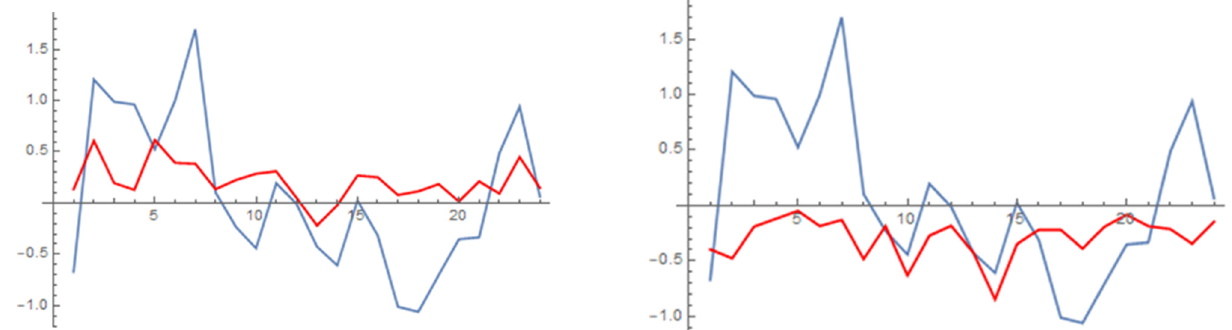
Figure A3. Examples of the Chinese sentiment index (blue) and its backward prediction (red) by a 10-layer scalar network from buy quotes (correlation ρ = 0.5841) and sell quotes (correlation ρ = 0.2934) of randomly selected traders. Traders are “uninformed”, i.e., they make predictions based on their observations through a network trained by an informed trader. Results are poorly repro- ducible.